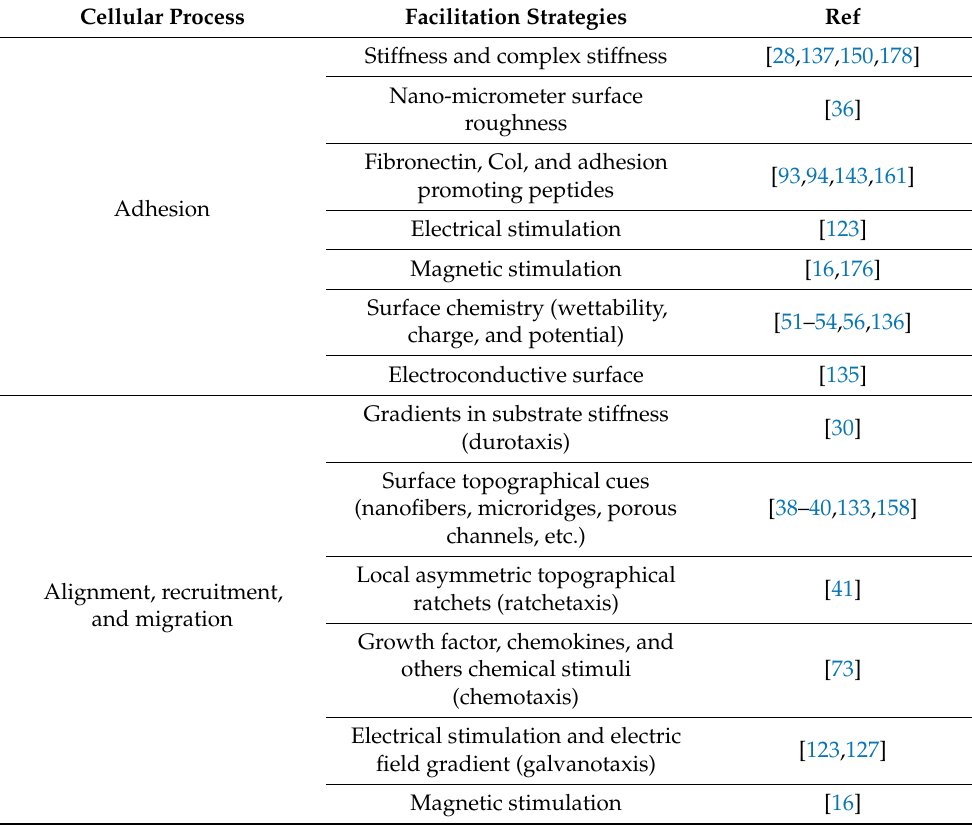
Table A4. Summary of different strategies for facilitation of cellular processes reviewed in this